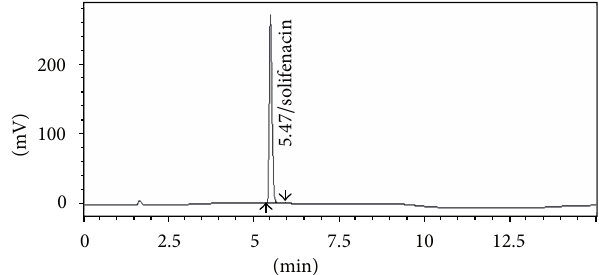
F 2: Typical HPLC chromatogram of blank solution.